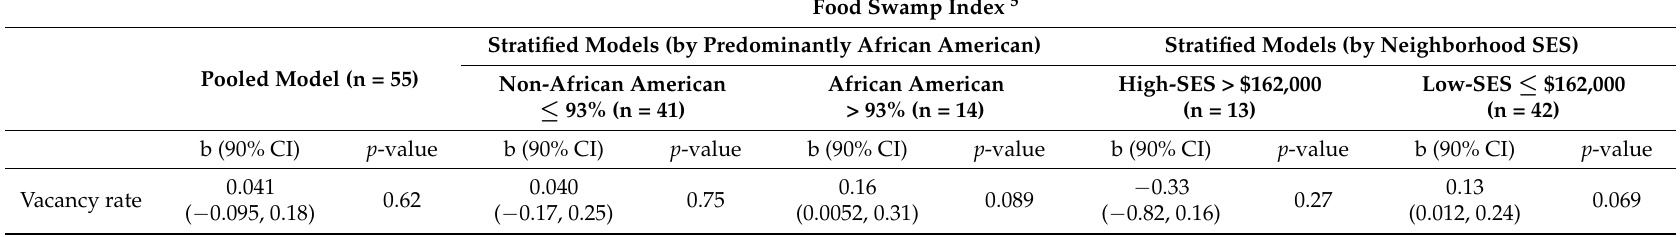
Table 3. Pooled model and sensitivity analyses 1 , testing whether the relationship between changes in vacancy rates 2 and changes in the food swamp index 3 differs when varying the definition for predominantly African American neighborhoods 4 and for neighborhood SES 5